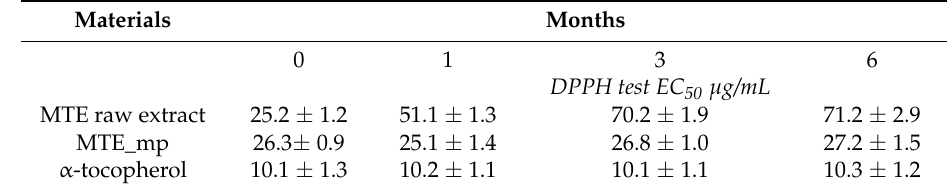
Table 2. Free-radical scavenging activity (DPPH test) expressed as the concentration of µ g/mL of sample necessary to decrease the initial DPPH concentration by 50% (EC 50 ) of the extract before (MTE raw extract) and after (MTE_mp) the microencapsulation